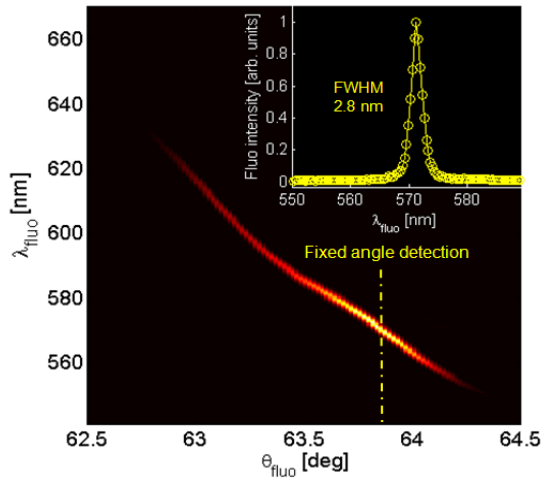
Figure 3. Experimentally measured angularly-resolved BSW-controlled fluorescence spectrum. Typical spectral widths at a given collection angle are below 3